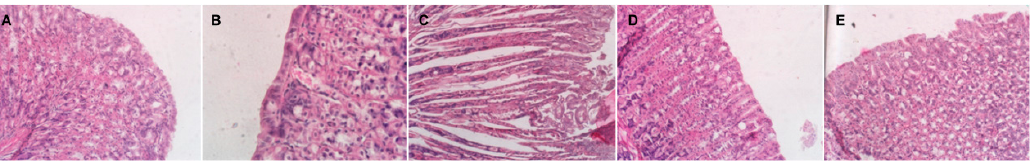
Figure 8. Pathological section of stomach (×10) after oral administration of ( A ) CMC-Na, ( B ) acetylsalicylic acid, ( C ) RBG intact, ( D ) RBG/ β -CD, and ( E ) RBG/HP- β -CD.